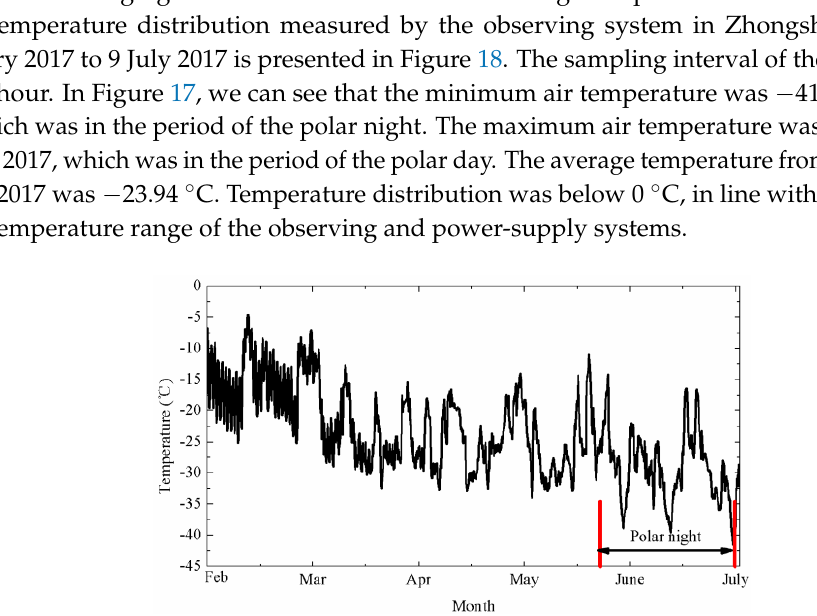
Figure 18. Daily air temperature measured by the observing system from 6 February 2017 to 9 July 2017 in Zhongshan Station, Antarctica. The area between the red lines is the polar night.